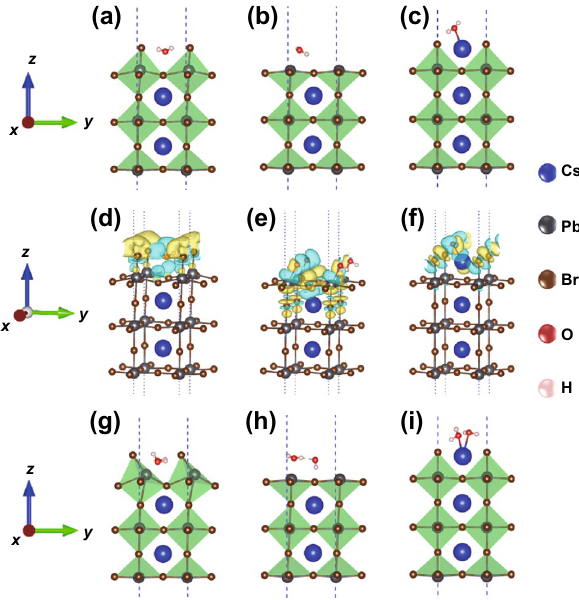
Fig. 4 Relaxed polyhedral models of CsPbBr 3 with ( a ) initial, b Br‑ vacancy, and ( c ) CsBr passivated structures after adsorption of one water molecule. d – f Diffrential charge density for ( a – c ), respectively. The yellow and cyan regions represent electron accumulations and depletions, respectively, where the isosurface value was set to 0.002 e Å −3 . Relaxed polyhedral models of CsPbBr 3 with ( g ) initial, ( h ) Br‑ vacancy, and ( i ) CsBr passivated structures after adsorbing two water molecules. Blue, gray, brown, red, and pink spheres represent Cs, Pb, Br, O, and H atoms,